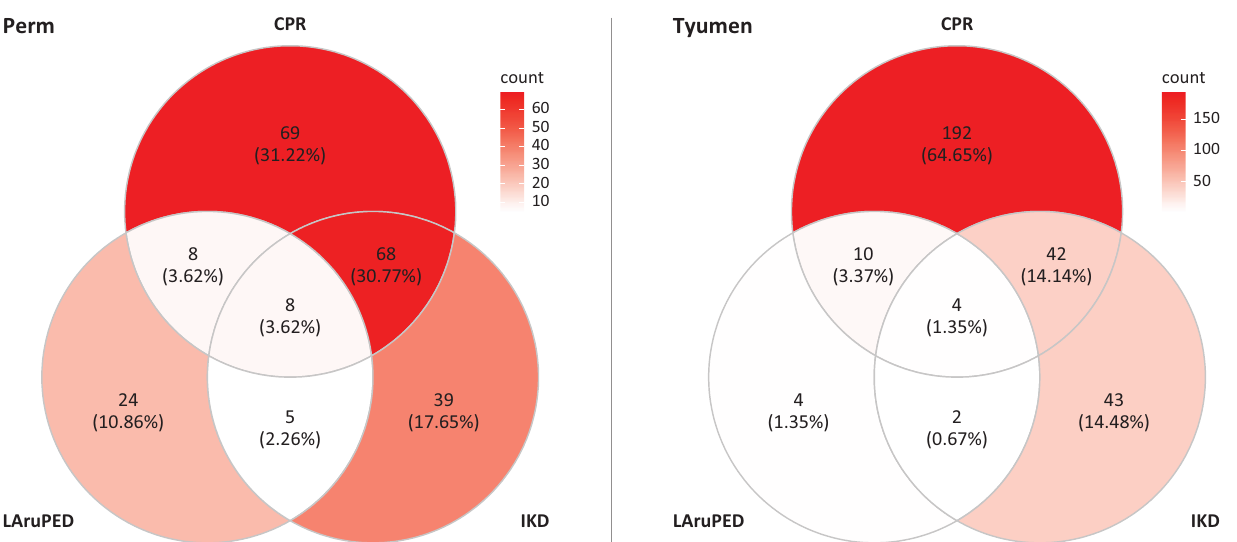
Figure 4. Overlap of three data sets, by region: Left panel shows Perm (March 16, 2007, through March 5, 2012); right panel shows Tyumen (January 1, 2008, through to March 5, 2012).